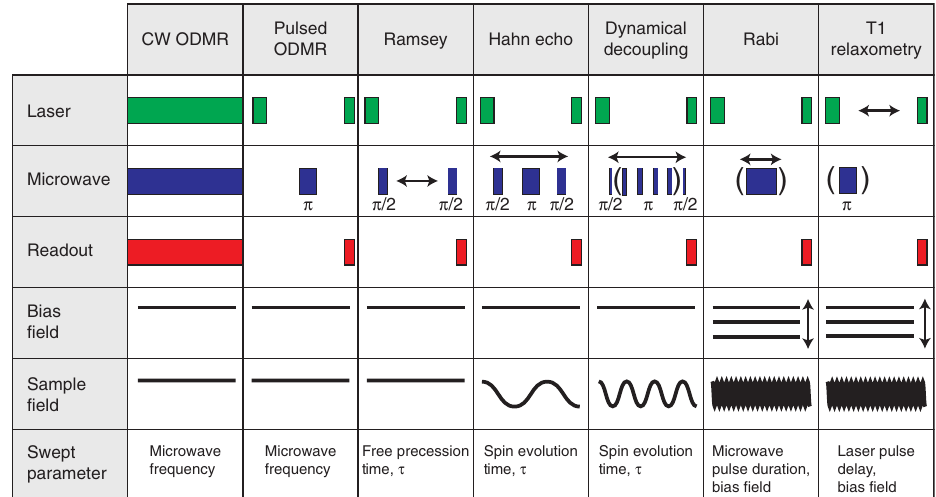
Figure 5: NV measurement protocols. Schematic of timing and duration of laser pulses, MW pulses, and readout sequences relative to the field being sensed for common NV diamond protocols. Swept parameters are indicated by arrows. Straight lines for the bias and sample fields indicate static magnetic fields, including the swept static bias field for Rabi and T relaxometry. Sinusoidal curves represent time-dependent sample fields, which are very 1 high frequency for Rabi and T relaxometry. 1